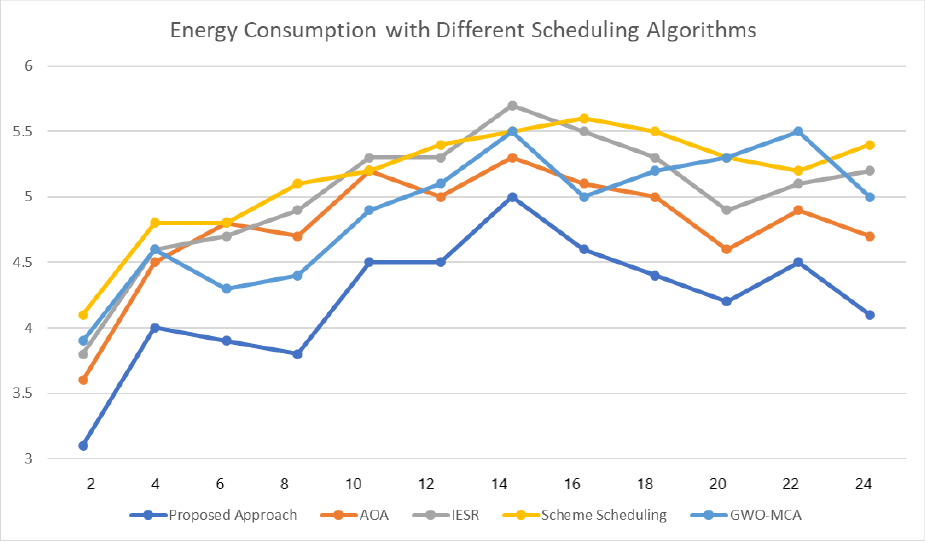
Figure 12. Results for energy consumption when different scheduling algorithms are